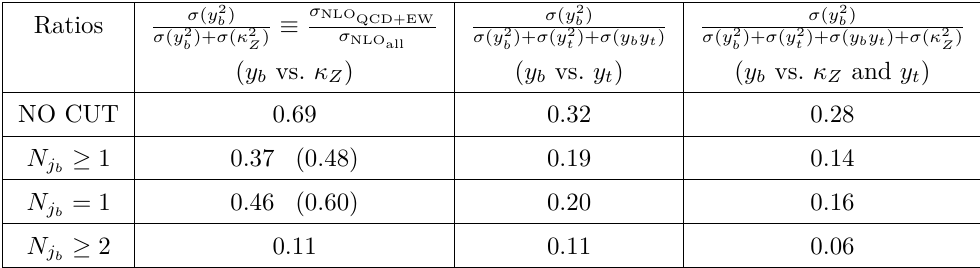
Table 4 . Fraction of the cross section scaling as y 2 for different phase-space cuts. The first column b is based on the results from our calculation in table 2. The second column is based on results from ref. [55]. The third column is based on the numbers in the first and second column. Details are explained in the